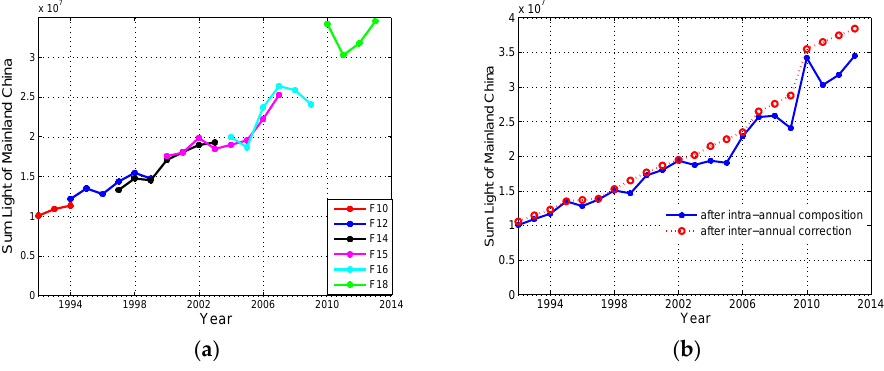
Figure 2. Summation of DN values over years for different satellites after preprocessing: ( a ) inter-calibration; ( b ) intra-annual composition and inter-annual correction.